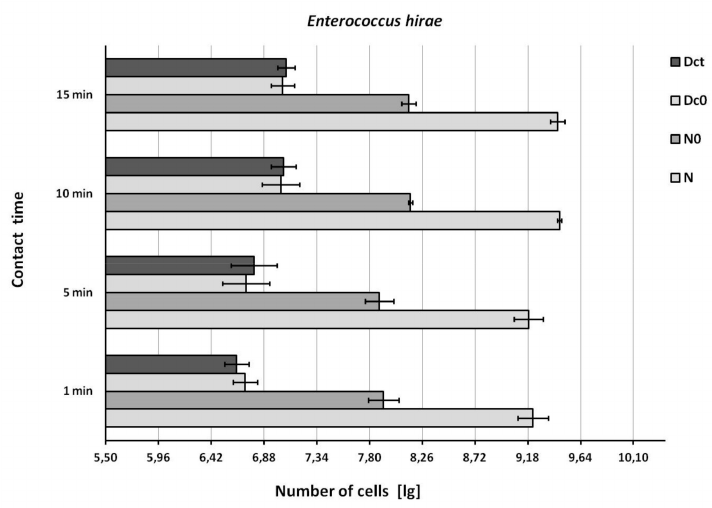
Figure 2. Recovery of Enterococcus hirae from the surface. N = density of test suspension (basic limit: 9.17 ≤ lg, N ≤ 9.70); N0 = density of the test suspension at the beginning of the contact time 0 (basic limit: 7.88 ≤ lg, N0 ≤ 8.40 ); Dc0 = drying control at the contact time 0 (basic limit: 6.88 ≤ lg, Dc0 ≤ 8.40); Dct = drying control at the end contact time t (basic limit: 6.88 ≤ lg, Dct ≤ 8.40). Shown are means and standard deviations.